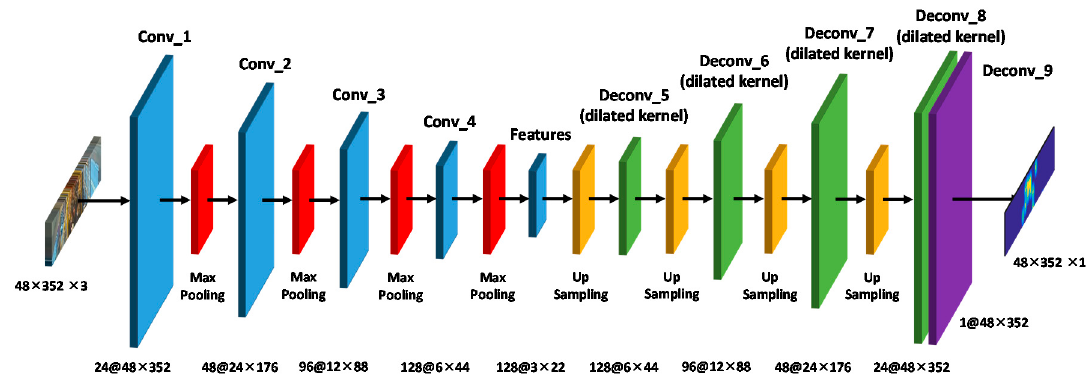
Figure 8. Architecture of the proposed convolutional autoencoder (CAE).